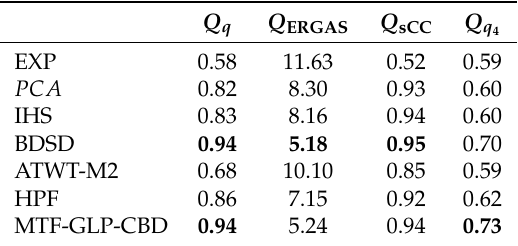
Table 6. IKONOS Roma Road scene, reduced resolution quantitative results. The bold number indicates the best performing PS method according to each quality metric.